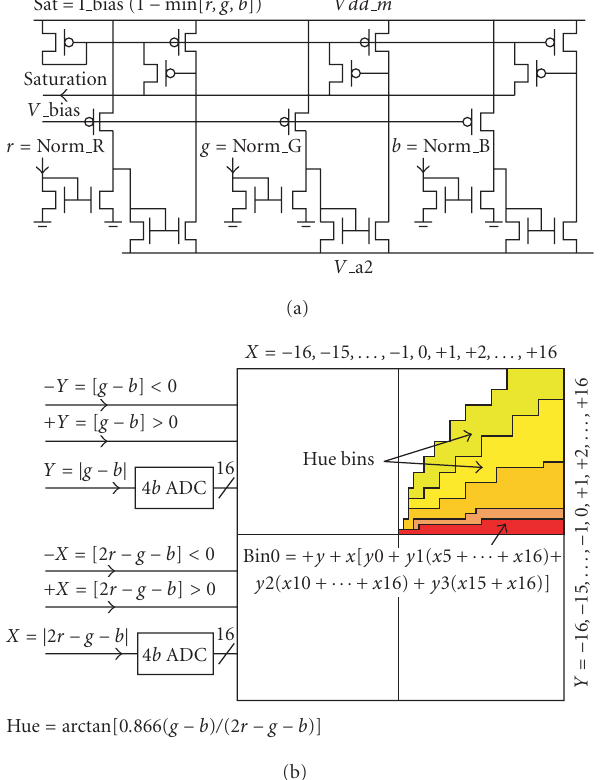
Figure 8: (a) Loser-take-all used for the saturation (S) computa- tion. Actually computes the winner of 1 −{ r,g,b } . (b) The Hue (H) mixed-signal lookup table.